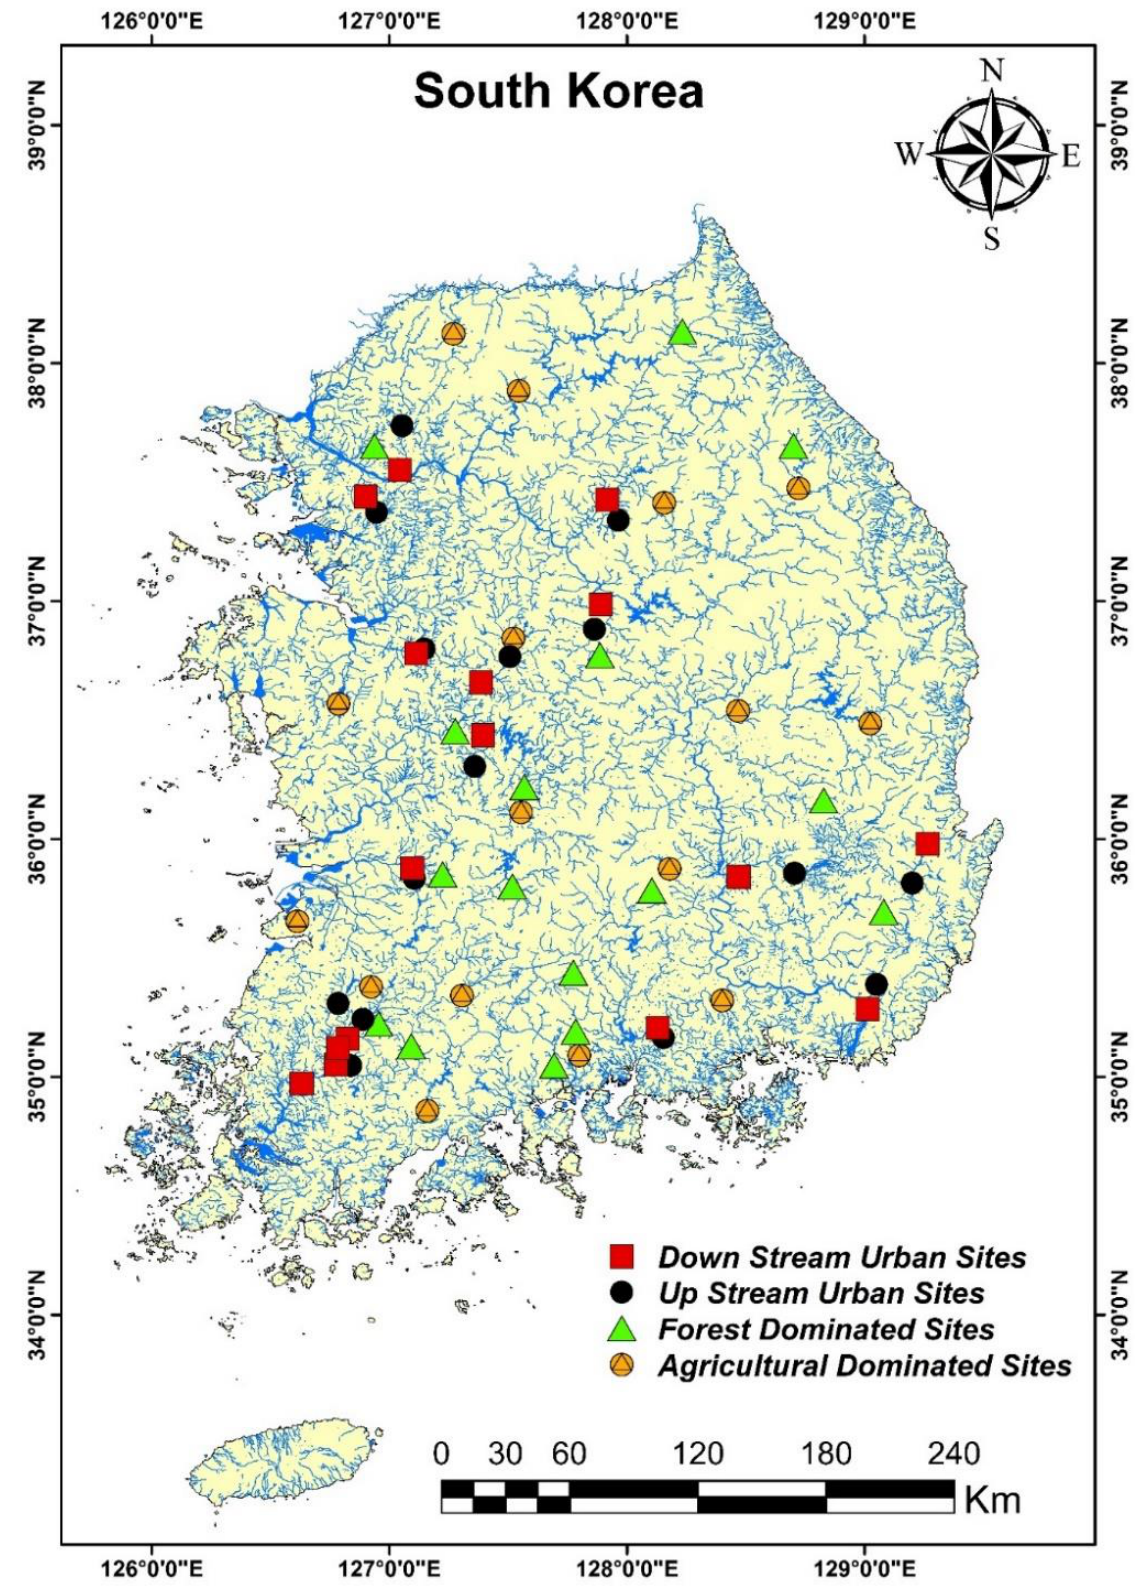
Figure 1. Map showing the distribution of the study sites (streams), divided into four land use patterns from the four river watersheds in South Korea.